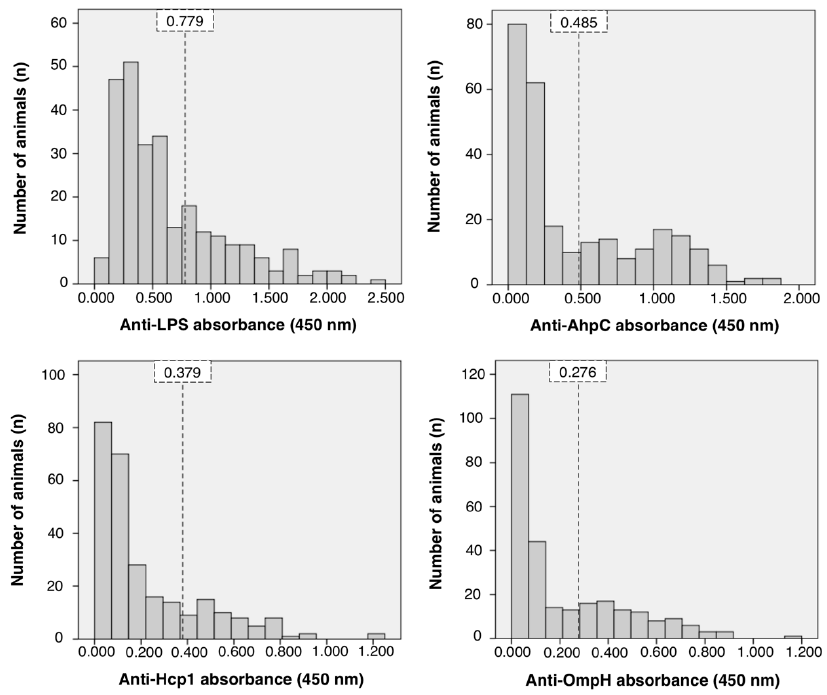
Figure 3. Distribution of absorbance values representing IgG against B. pseudomallei proteins; lipopolysaccharide (LPS), alkyl hydroperoxide reductase subunit C (AhpC), hemolysin-coregulated protein 1 (Hcp1), and putative outer membrane porin protein (OmpH). Vertical striped lines describe the cut-off value of each assay at a 99.7% confidence interval.